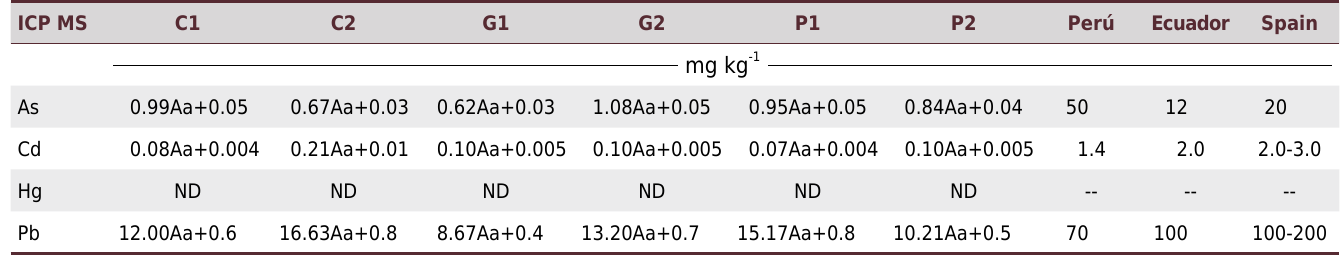
Table 1. Analysis of heavy metals (As, Cd, Hg, and Pb), in the soils of Páramo , potato cultivation, and cattle